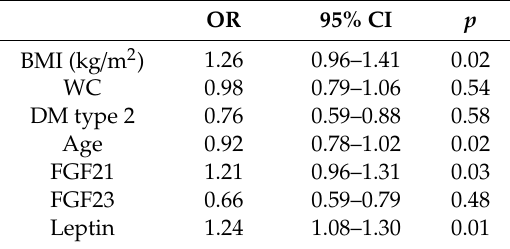
Table 7. Multivariate logistic regression